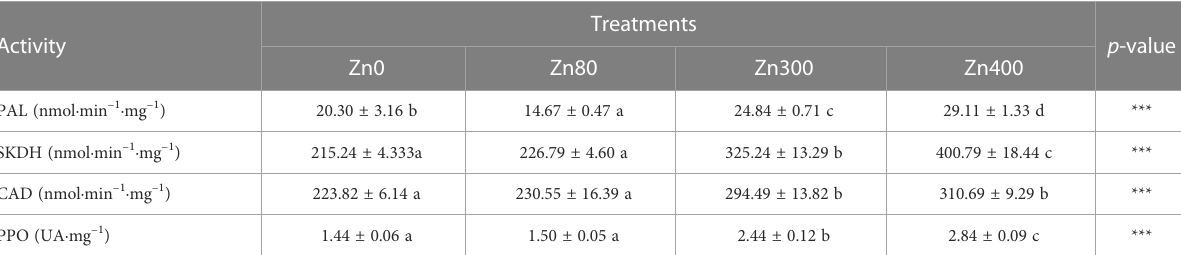
TABLE 4 Effects of ZnSO 4 Effects of ZnSO4 treatments on phenolic compounds metabolism related enzymes activity in the leaves of Cd- contaminated K. obovata.